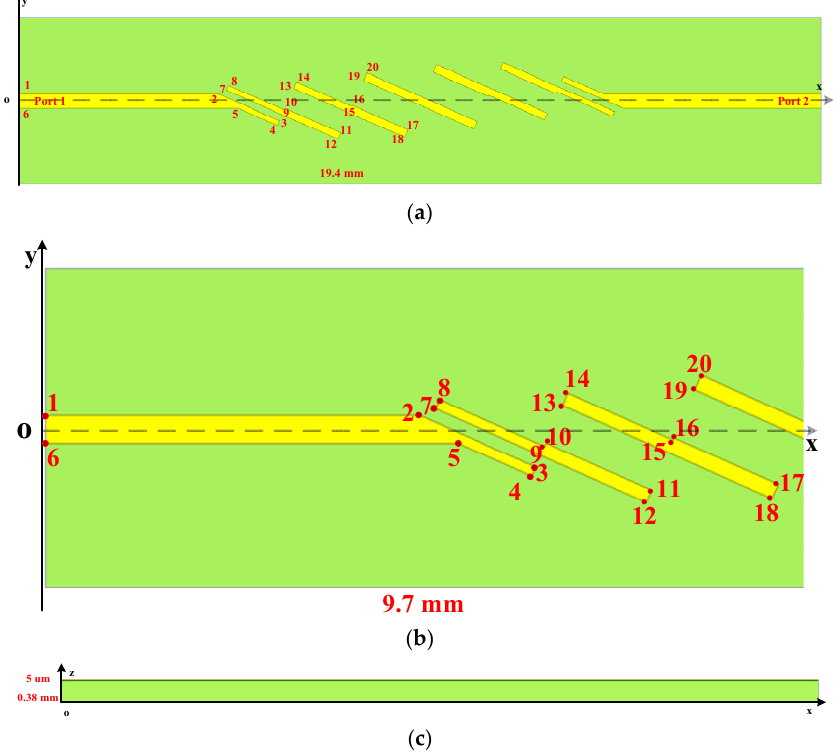
Figure 2. The sketch picture of the filter for sensors system: ( a ) top view; ( b ) top view enlargement; ( c ) front view.